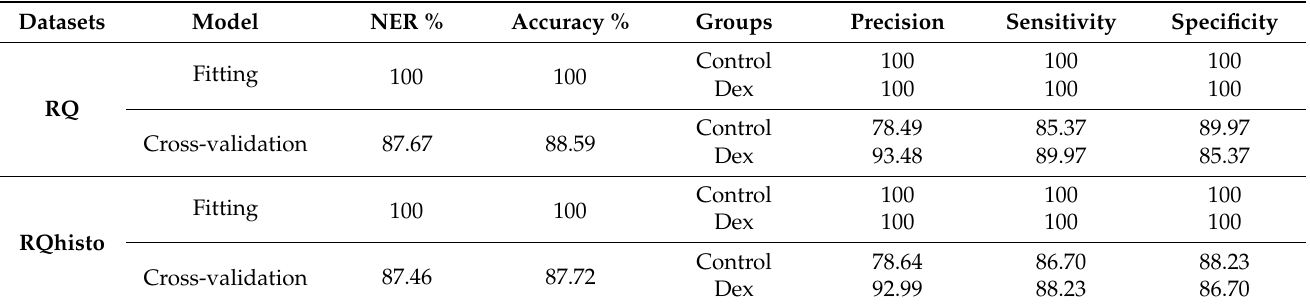
Table 4. Classification performances in fitting and cross-validation for Supervised Kohonen Networks applied to the RQ dataset (a) and to the RQhisto dataset (b), reporting Non-Error-Rate % (NER), Accuracy %, Sensitivity, Specificity and